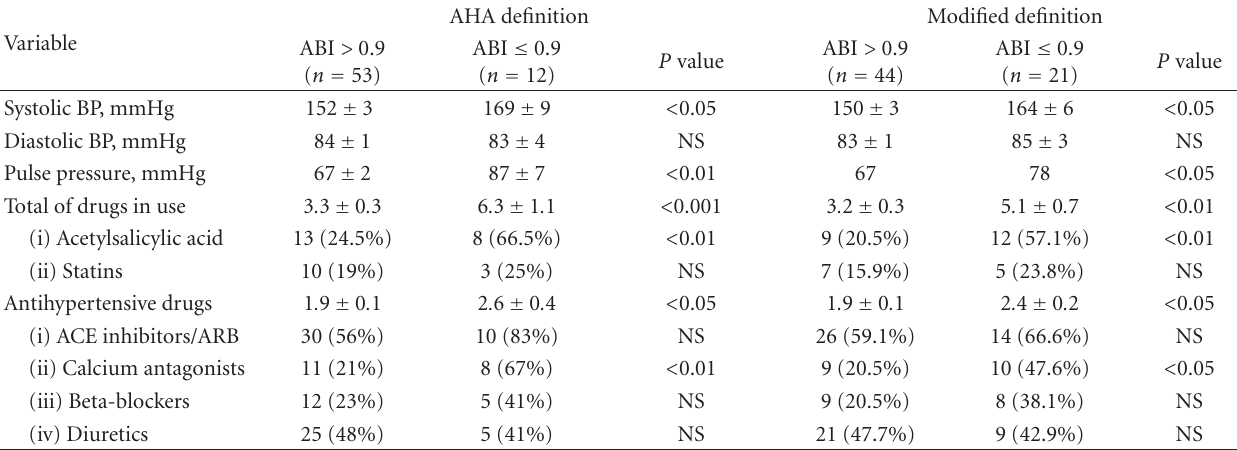
Table 3: Blood pressure levels and drugs in use in normal and low ankle-brachial index (ABI) groups divided by American Heart Association (AHA) definition and by modified